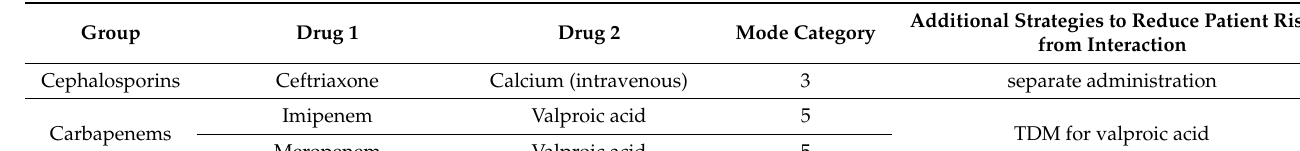
Table 2. DDIs (n = 65) including anti-infectives and rated clinically relevant by expert panel.